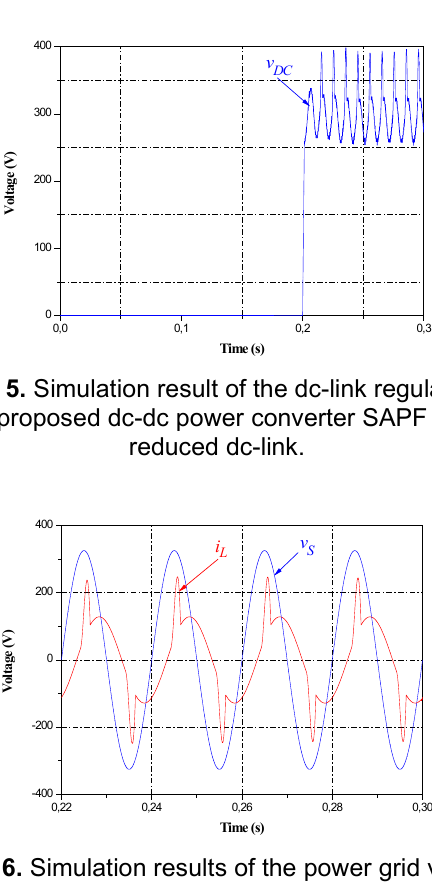
Figure 6. Simulation results of the power grid voltage, v S , and the load current, i L , in both